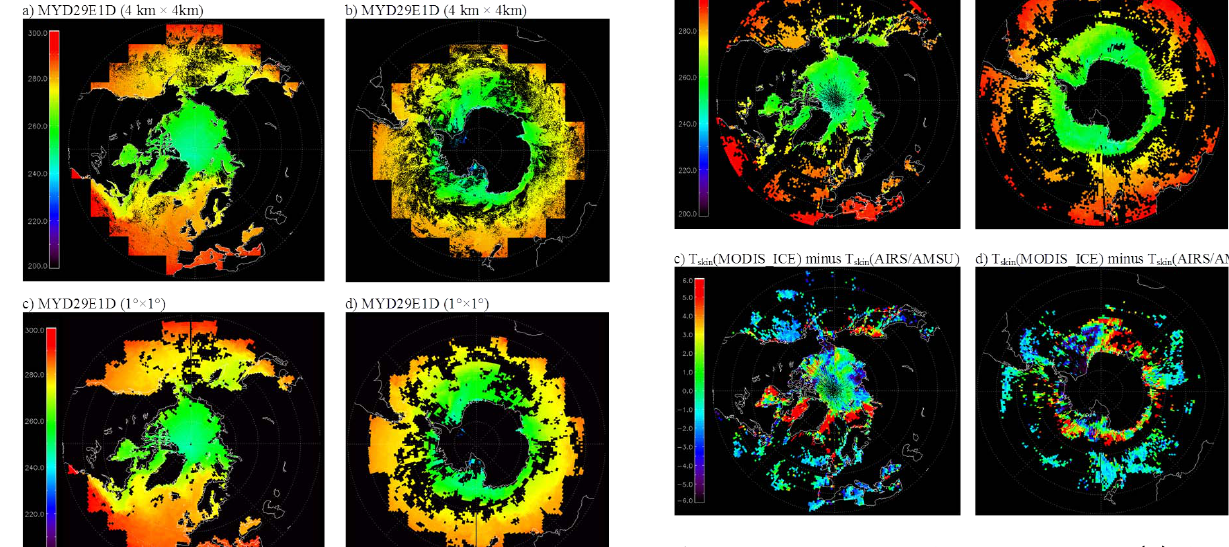
Fig. A2. 9-day composite surface skin temperatures (K) of AIRS/AMSU over the (a) Northern Hemisphere during the days 106–114, 2003, and (b) Southern Hemisphere during the days 258–266, 2003, (c) and (d) the difference between T skin (MODIS ICE) and T skin (AIRS/AMSU).